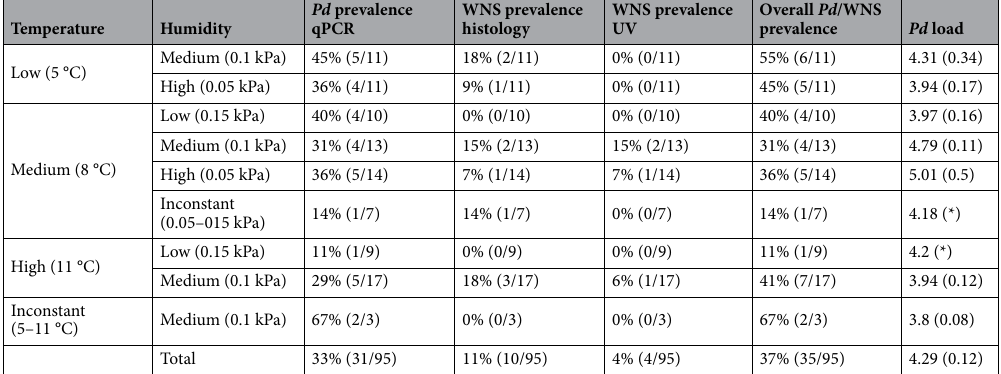
Table 1. Signs of Pd infection or WNS disease for tri-colored bats ( Perimyotis subflavus ) exposed to different temperature and humidity regimes. We report the proportion of bats with positive detections of Pseudogymnoascus destructans ( Pd ) detected by qPCR ( Pd Prevalence by qPCR, the proportion of bats with signs of Pd infection from histological examination (WNS Prevalence histology) and by fluorescent